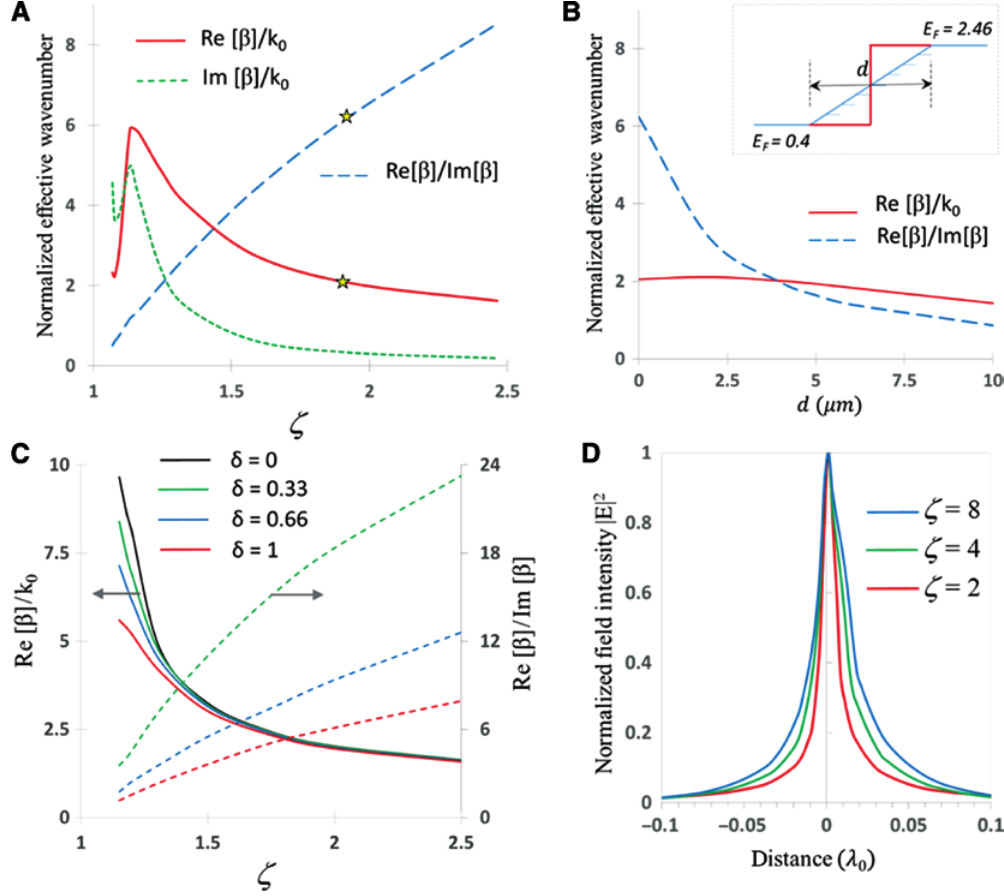
Figure 4: Numerical simulation of the line wave’s mode properties under different conditions. (A) Propagation characteristics of LWs with different ζ values supported by the graphene metasurface at 3 THz, (B) associated propagation characteristic of the structure at ζ = 1.94 in the case of non-abrupt, linear change in Femi energy of graphene – as illustrated in the inset – over different distances across the line interface, (C) general relation of confinement and propagation factors of LWs versus ζ with pre- = δ Re[ Z scribed values of loss factor (Re[ Z ] ] ), and (D) general field intensity profile distribution in the transverse direction to the line s new s actual interface, over the surface, for LWs of different ζ